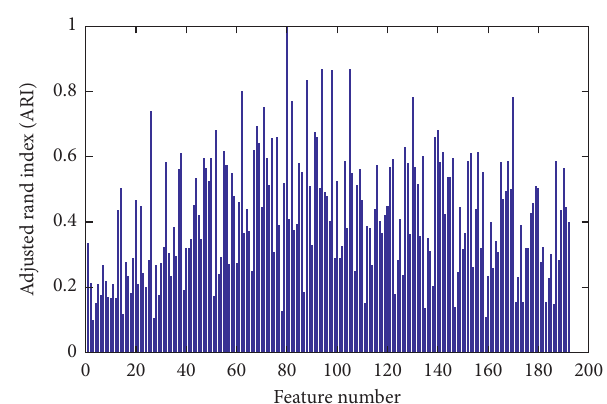
Figure 27: The adjusted rand index.